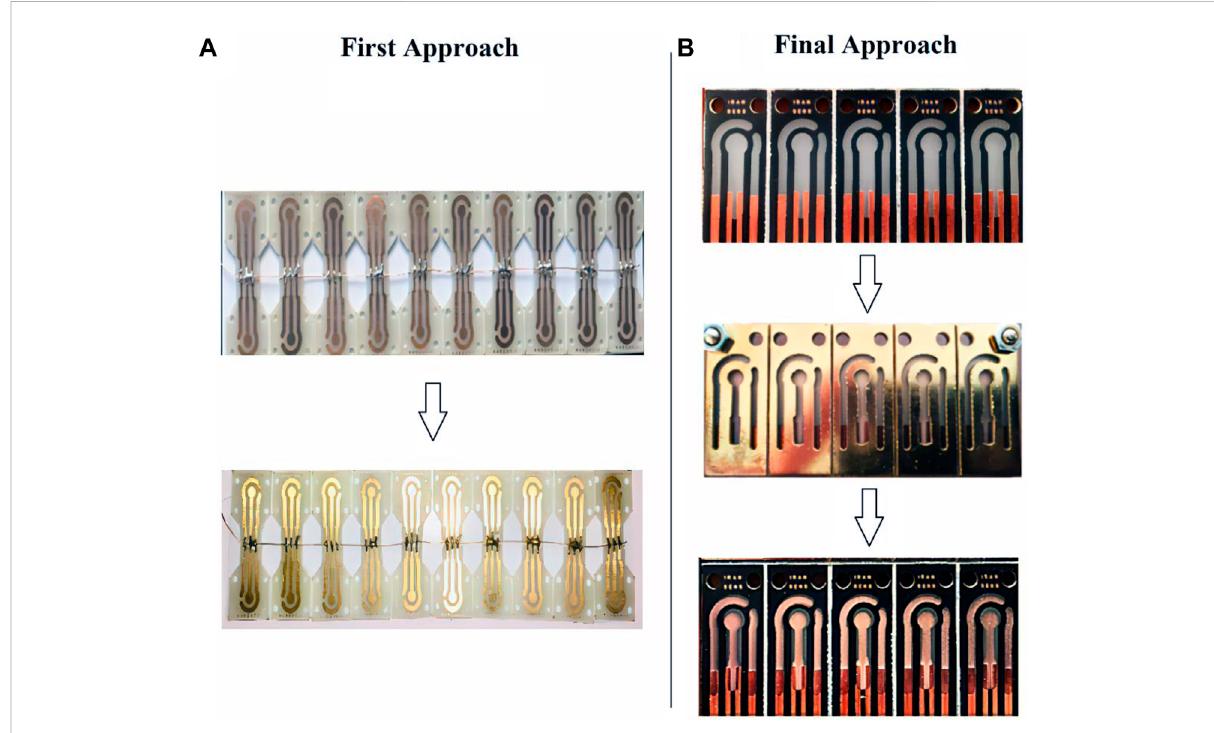
FIGURE 2 (A) First ApproachFabrication: Gold electroplating on copper electrodes in a two-step process, (B) Final Approach Fabrication: Gold sputtering on PCB